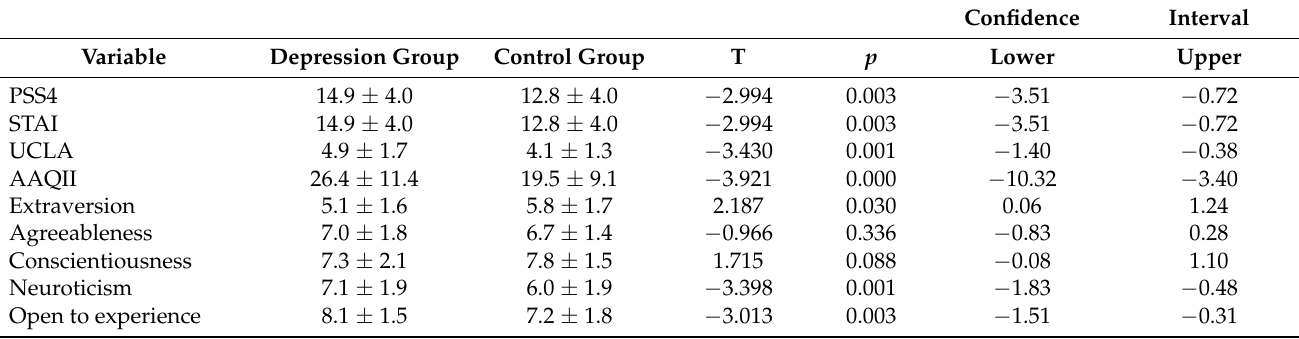
Table 2. Results of psychological variables